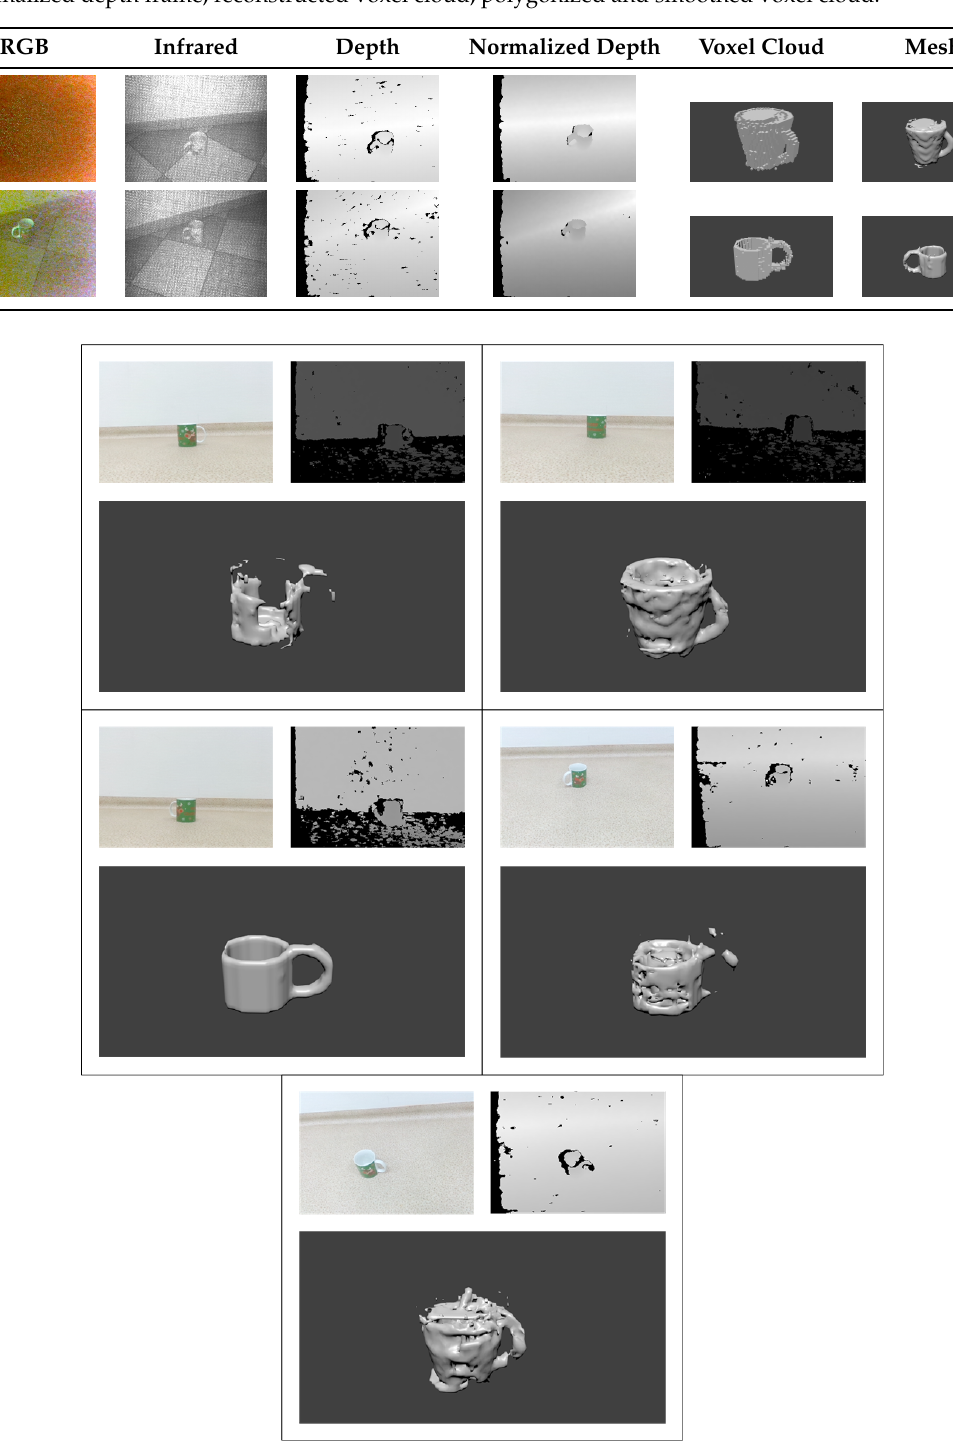
Table 4. 3D reconstruction in low illumination conditions: RGB frame, infrared frame, depth frame, normalized depth frame; reconstructed voxel cloud; polygonized and smoothed voxel cloud.